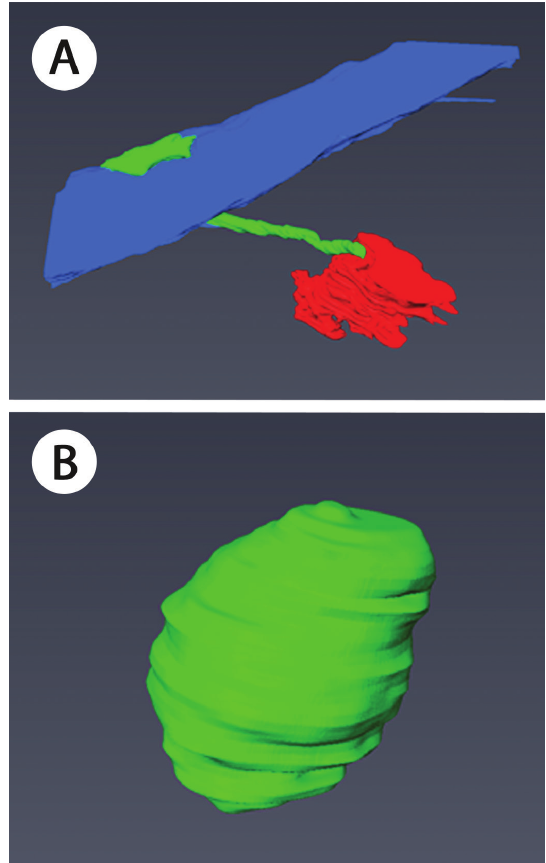
Figure 8. A A three-dimensional model of a class 3 gland cell found underneath the cuticle. The model shows the cuticle in blue, the gland cell in red, and then secretory duct connecting them in green B A three-dimensional model of a lamellar